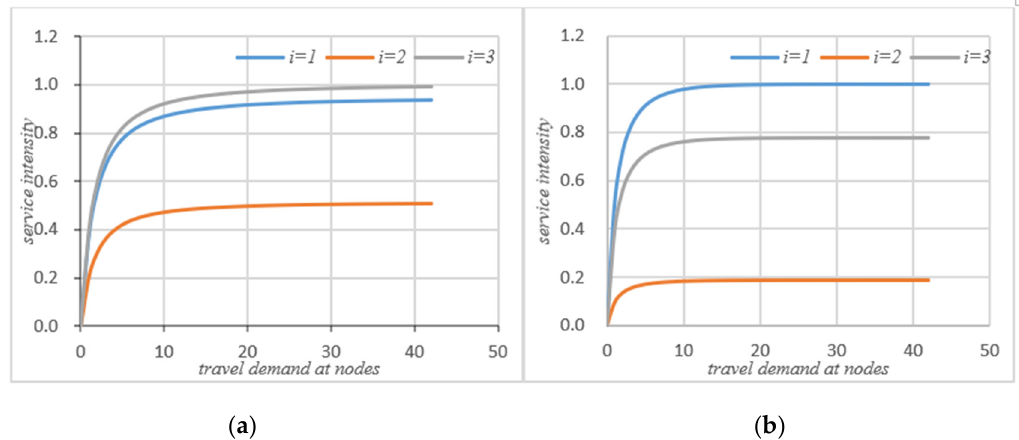
Figure 6. ( a ) Service intensity without self-balancing; ( b ) service intensity with self-balancing.